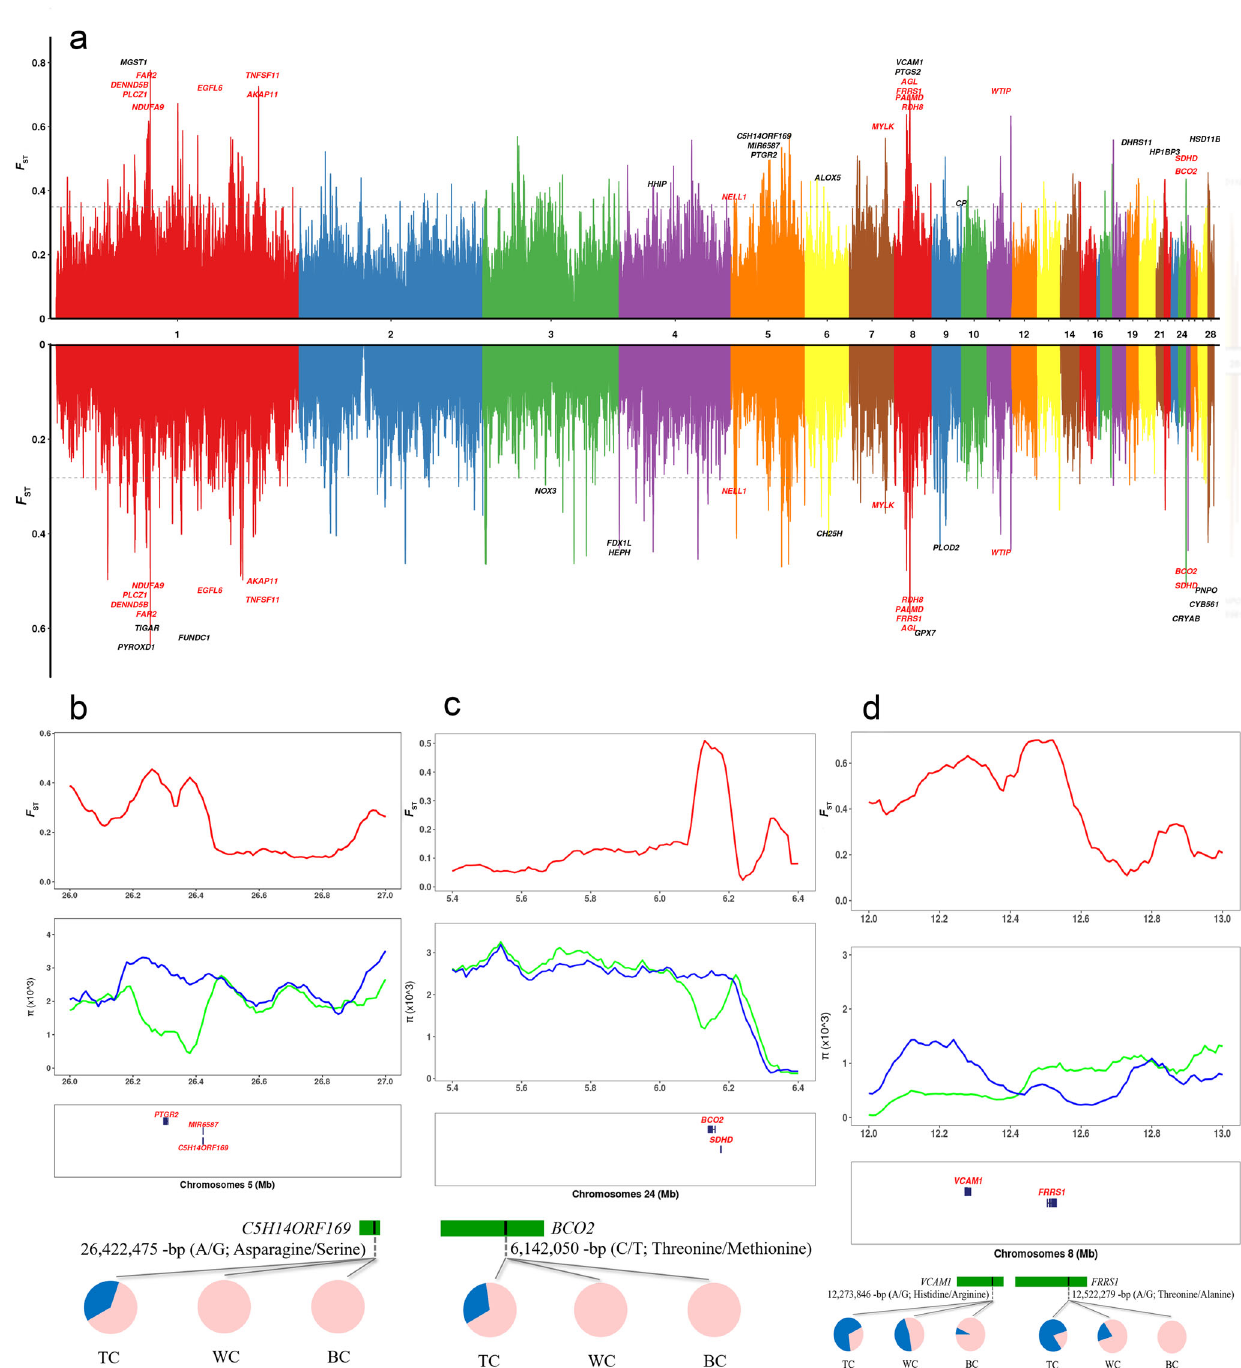
Fig. 3 Selection signals for adaptation to high-altitude hypoxia of TC. a Pairwise fi xation index ( F ST ) in 100-kb sliding windows across autosomes between TC and other chickens (upward coordinate axis: TC/BC; downward coordinate axis: TC/WC). The black horizontal dashed line corresponds to the genome-wide signi fi cance threshold ( F ST = 0.35 and 0.28 for TC/BC and TC/WC, respectively). Genes located in divergence regions and annotated by KEGG are indicated by their gene names. Overlapping candidate genes in two selected regions are marked in red. b – d Three extreme CDRs, which are found close to the genes in the pathways of “ oxidation-reduction process ” were enriched for sites on chromosomes 5 ( b ), 24 ( c ), and 8 ( d ). The pie charts represent the spectrum of allele frequencies at the non-synonymous loci of the focused genes C5H14ORF169 , BCO2 , VCAM1 and FRRS1 in TC and other chicken breeds. The variant allele is indicated in blue, whereas the reference allele in